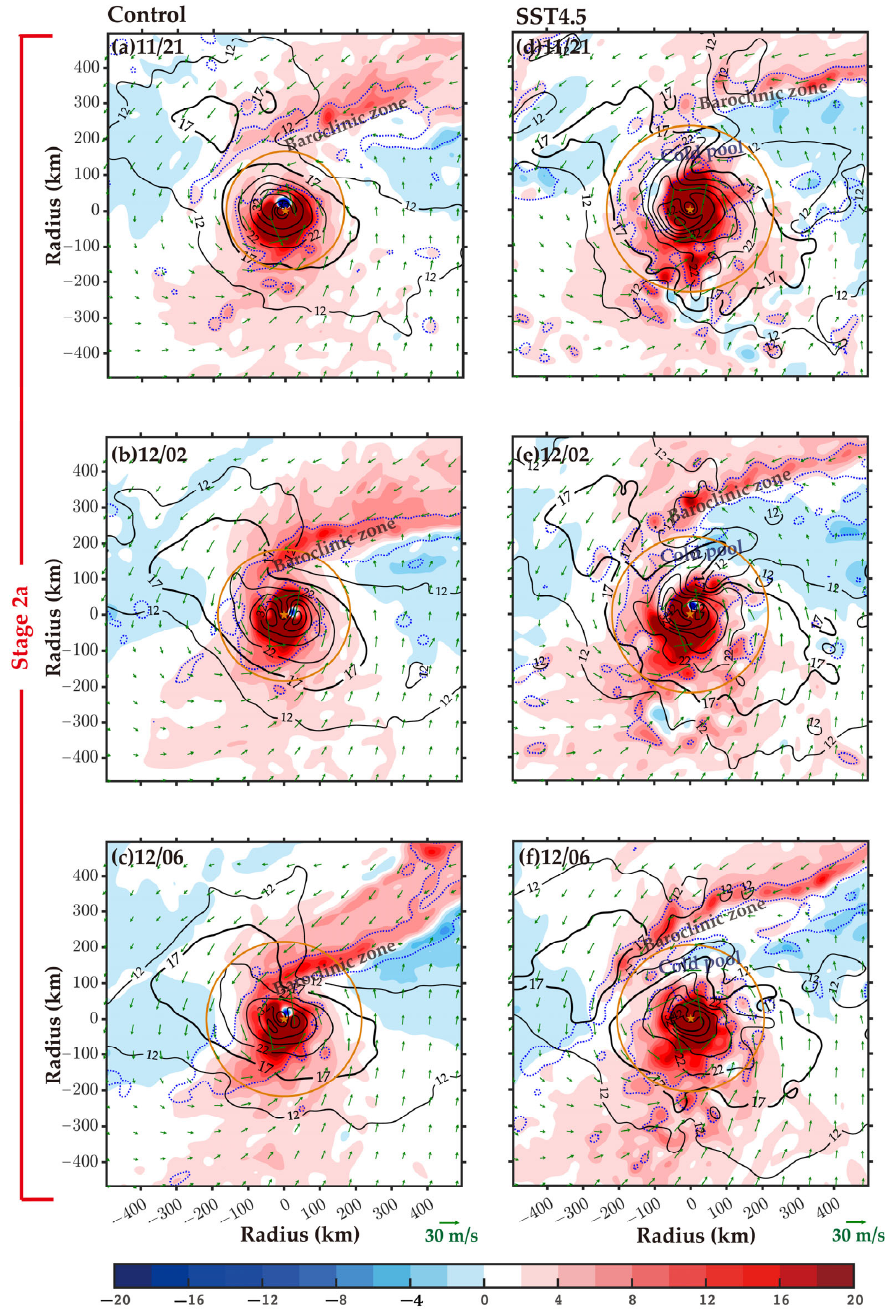
Figure 9. ( a – c ) Horizontal structure of radial absolute vorticity flux (RAF; shaded; m s − 1 h − 1 ), tangential velocity (black contours; 5 m s − 1 interval), absolute vorticity (blue dotted contour at 15 × 10 − 5 s − 1 ), and horizontal flow vectors (green arrows) at the model’s lowest level at 11/21, 12/02, and 12/06 in the control, respectively. The horizontal and vertical axes indicate the distance (km) from the storm center (orange pentagram). The orange circles indicate the R17 of the cyclone. ( d – f ) As in ( a – c ) but for SST4.5. The words “Baroclinic Zone” and “Cold pool” indicate their approximate locations. For clear visualization, the RAF, tangential velocity, and absolute vorticity are smoothed. The D3 output is utilized.